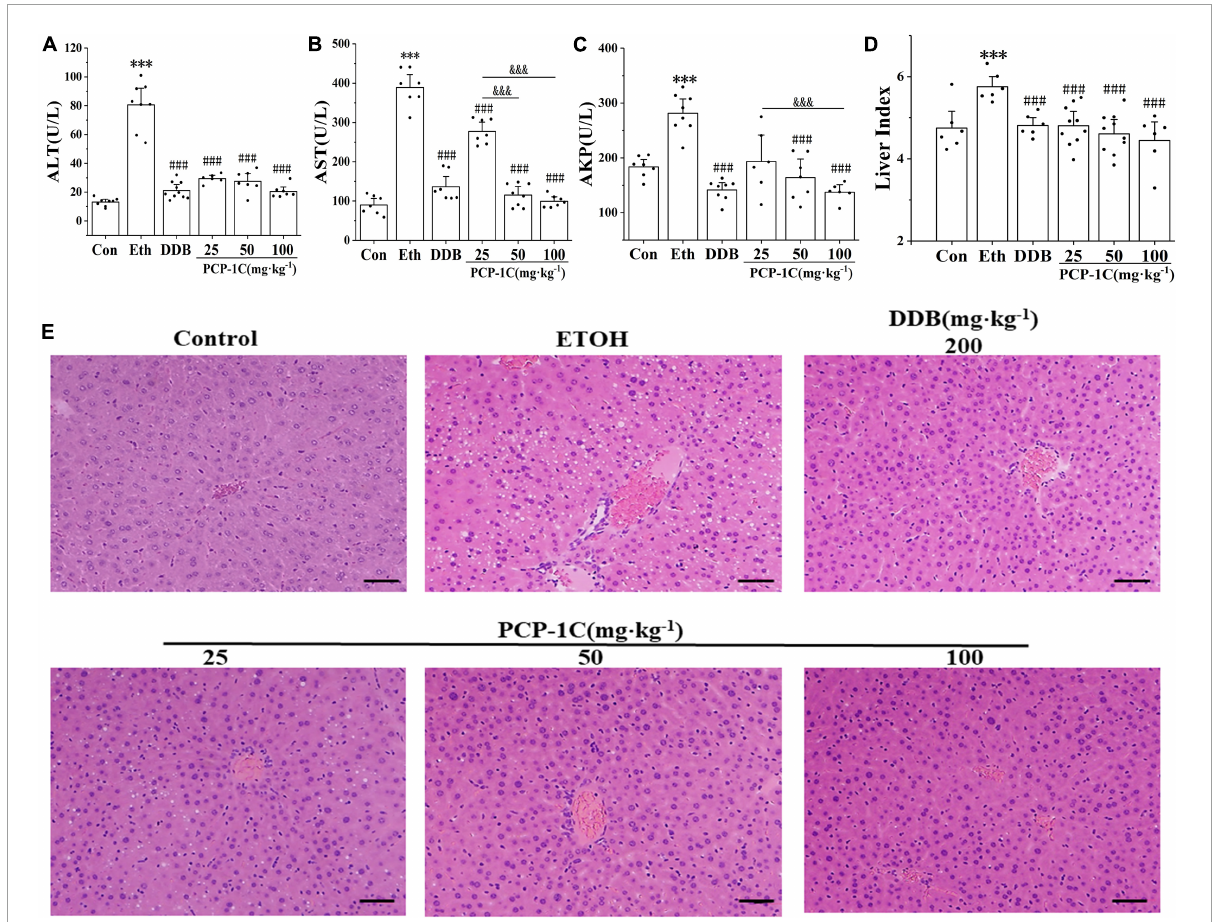
FIGURE1 Effect of PCP-1C on general parameters of the ALD mice. (A) The serum levels of ALT, (B) AST, (C) AKP, and (D) mouse liver index. (E) Liver H&E staining of mice in each group ( × 200, scale 50 µ m). The results are presented as mean ± SD ( n ≥ 6). ∗∗∗ P < 0.001 vs. the control group; ### P < 0.001 vs. the model group; &&& P < 0.001 represents significance between PCP-1C